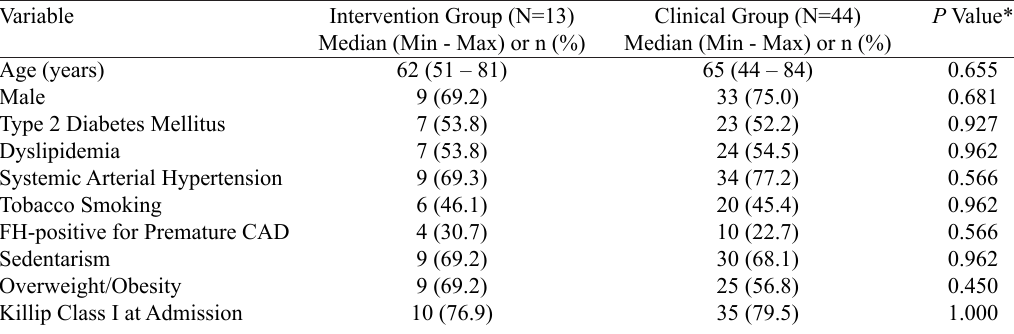
Table 1. Baseline clinical characteristics of patients admitted with STEMI and who underwent primary